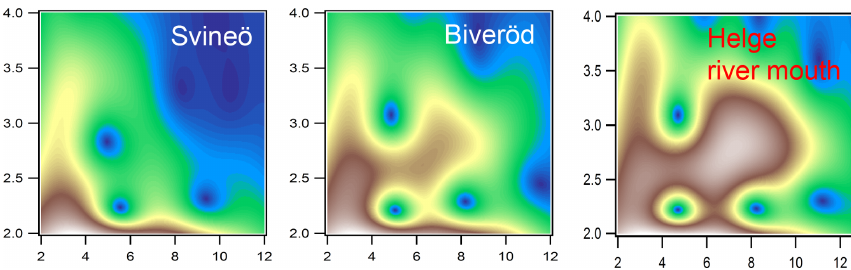
Figure 4. Morlet wavelet transforms ( η = 4; σ = 2) of EXAFS data of the two upstream samples from Svineö and Biveröd and the river mouth of the Helge catchment (white represents autumn and red represents spring), plotted as a function of k (Å − 1 ) on the x axis and R (Å) on the y